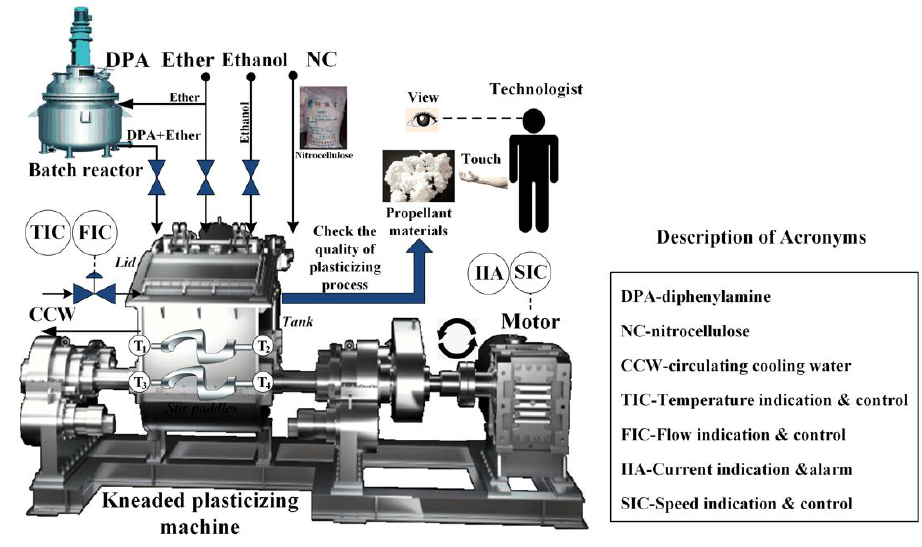
Figure 1. The process flow diagram of the plasticizing process.